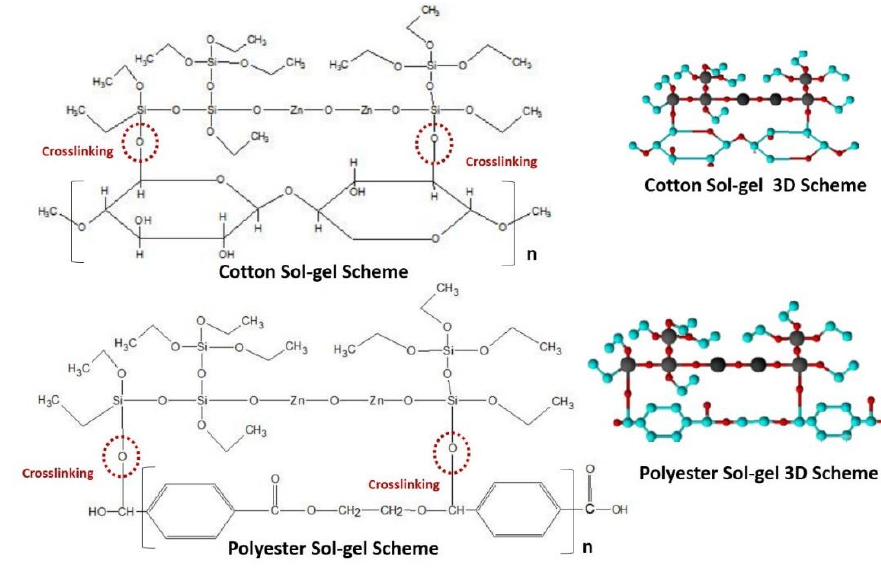
Figure 1. Reactions scheme of cotton and polyester .